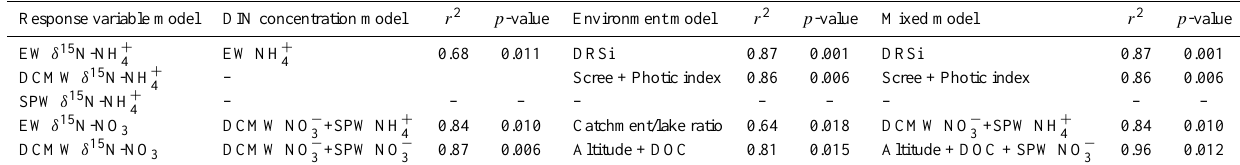
Table 5. Regression models relating isotopic composition to explanatory variables. Models based on dissolved inorganic nitrogen concen- tration, environmental variables and mixed models are